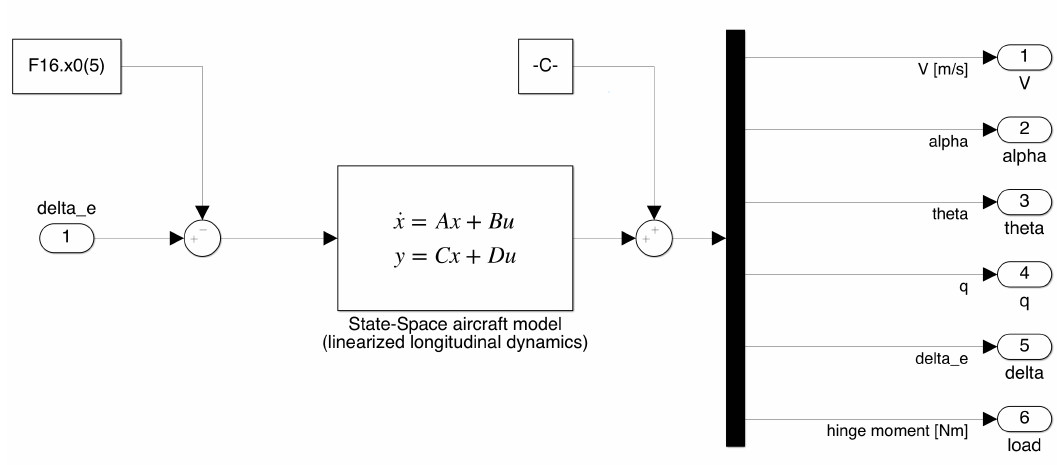
Figure 4. F16 longitudinal dynamics model